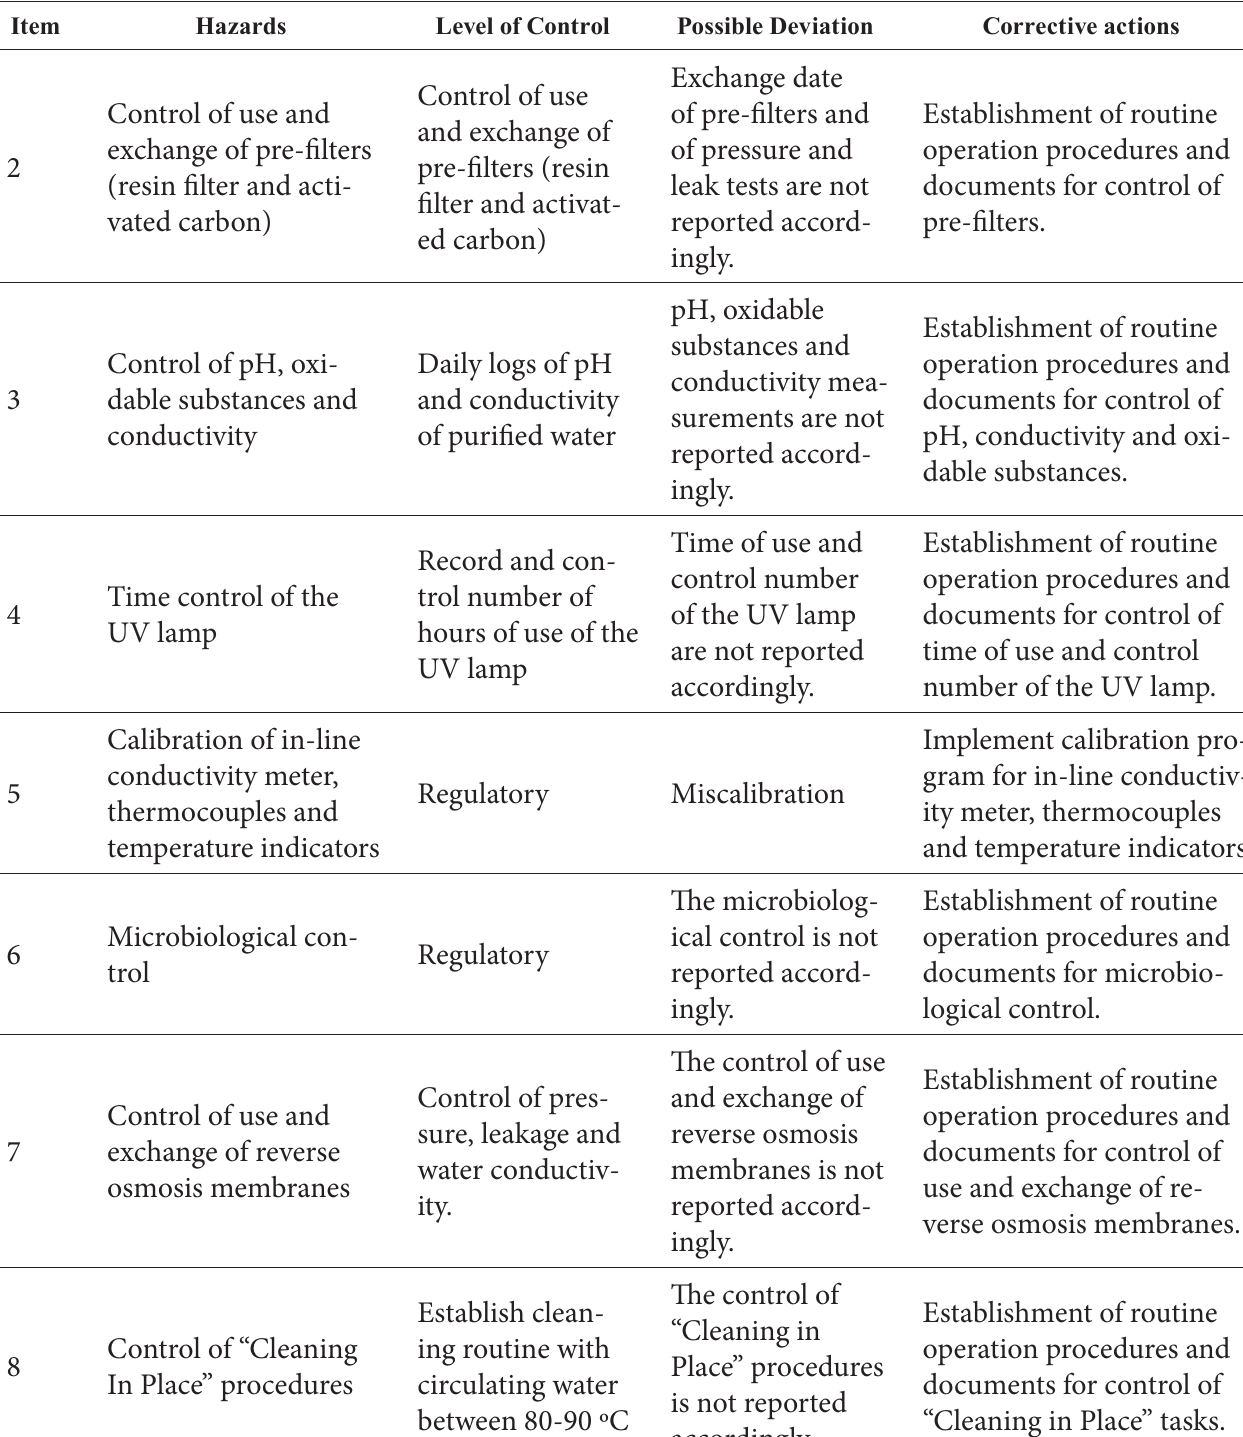
TABLE I - P otential hazards identified during the HACCP analysis of the water purification system Item Hazards Level of Control Possible Deviation Corrective